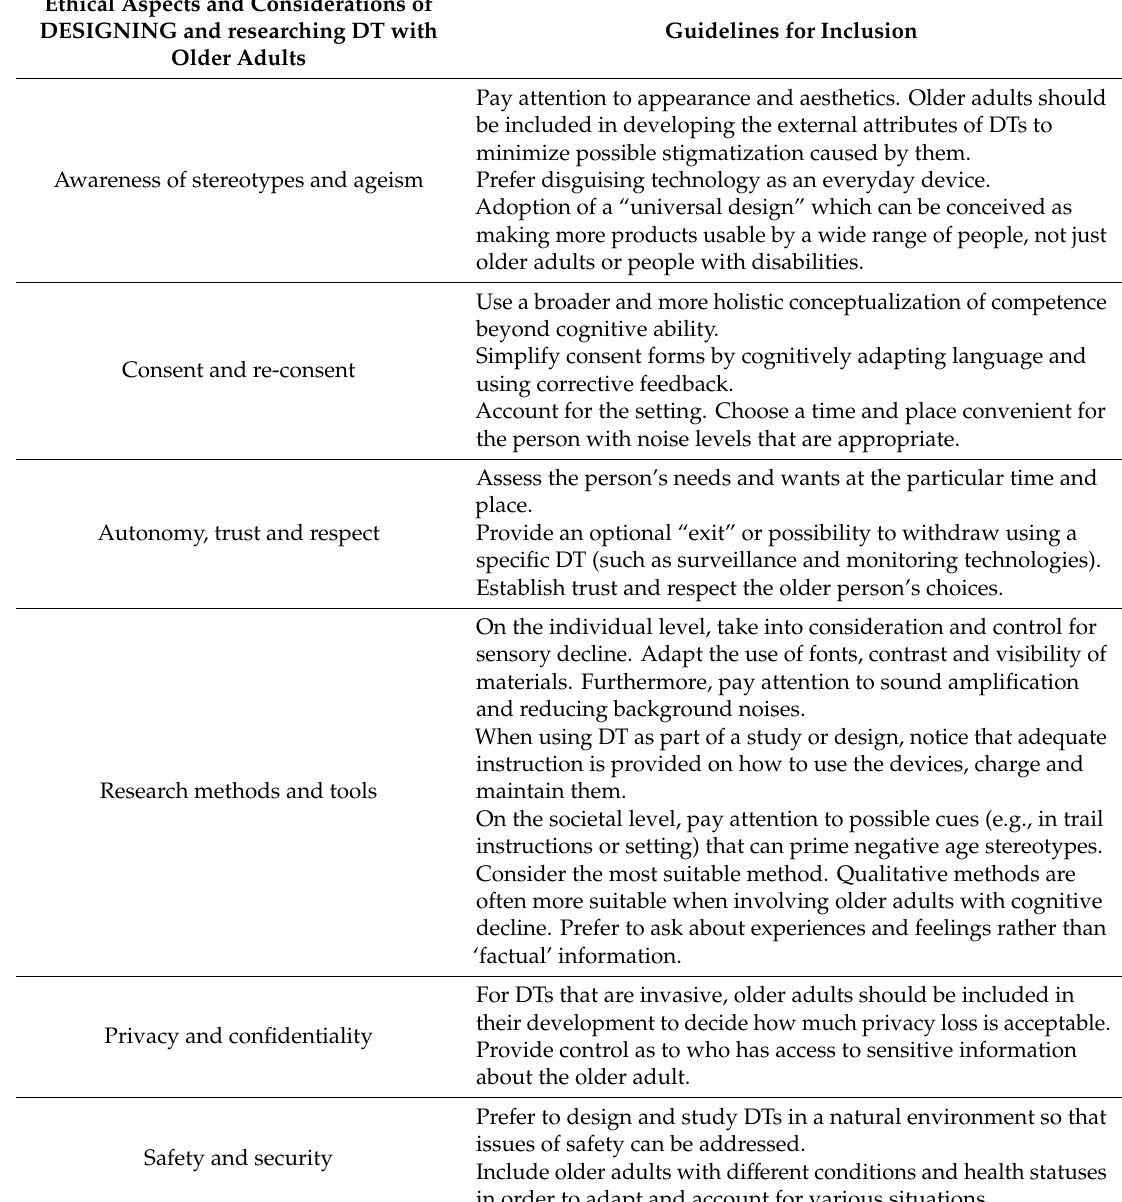
Table 1. Summary of ethical considerations and guidelines for inclusion of older adults in research and design of digital